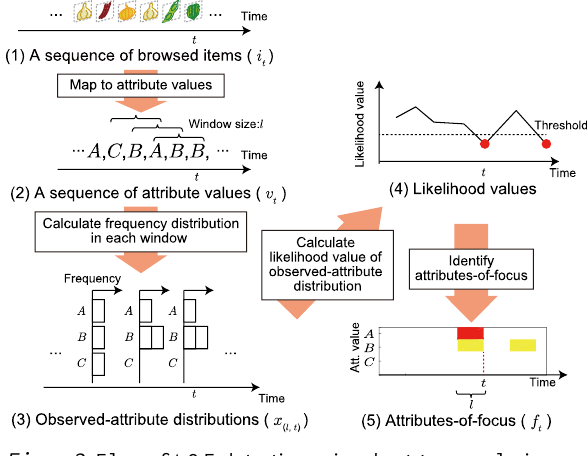
Figure 3. Flow of AOF detection using short-term